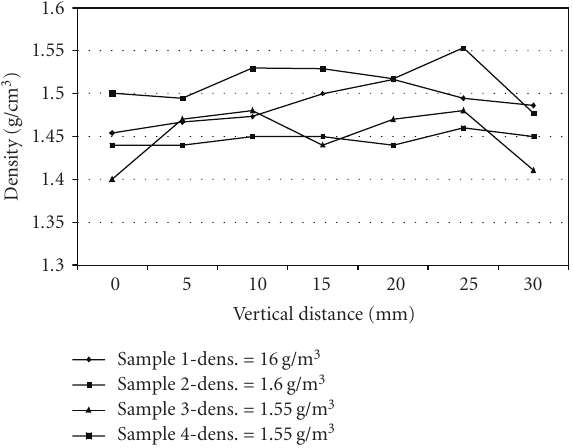
Figure 2: Vertical variation of soil density in artificially compacted soil